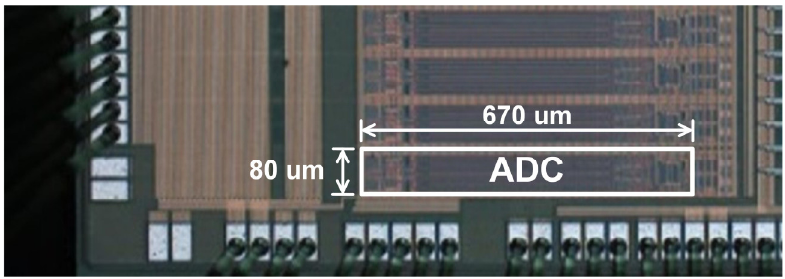
Figure 12. Die photograph.